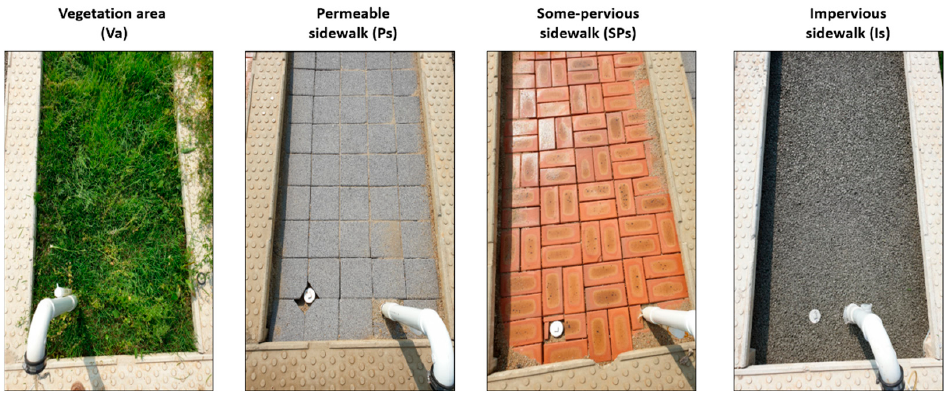
Figure 2. Classification of experiments according to 4 ground materials.